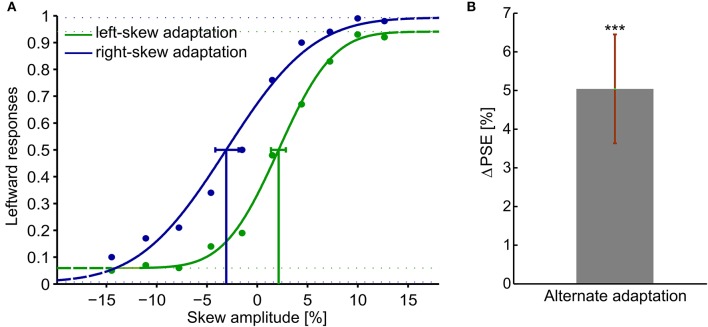
Adaptation aftereffects in response to skewed natural image sequences. Adaptation aftereffect is estimated by the PSE, the skew amplitude at which observers respond equally likely that the test plaid checkerboards are skewed to the right and to the left. (A) psychometric functions of the average response of all the observers. The gaussian fitted function, data points and the confidence intervals at PSE are shown in green for the left-skew adaptation aftereffects and in blue for the right skew adaptation aftereffects. (B) The overall ΔPSE of all the 10 observers after left and right skew adaptation. The error bar shows the standard error. ***t-Test result of p < 0.05.